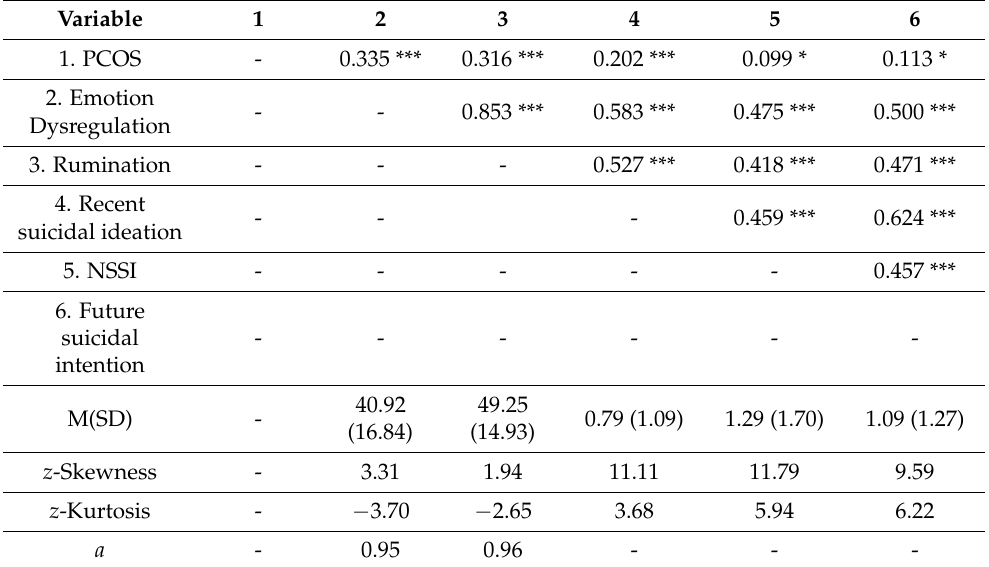
Table 2. Descriptive statistics, reliability, and bivariate correlations ( n =